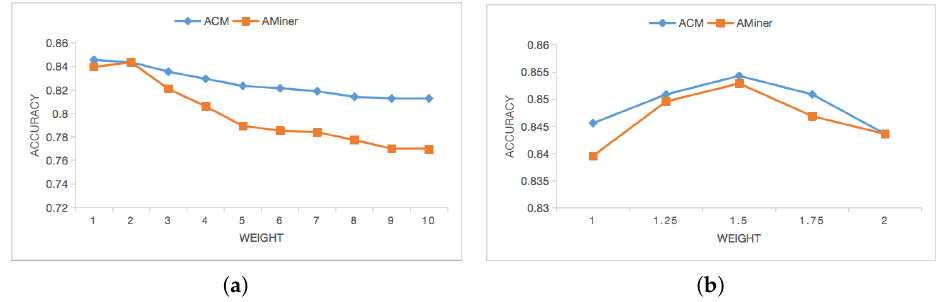
Figure 6. ( a ) Weight range from 1 to 10. ( b ) Weight range from 1 to 2. The experimental result of the inductive learning task. It reflects the influence of assigning different weights to important nodes on the accuracy in the node classification task of new nodes.